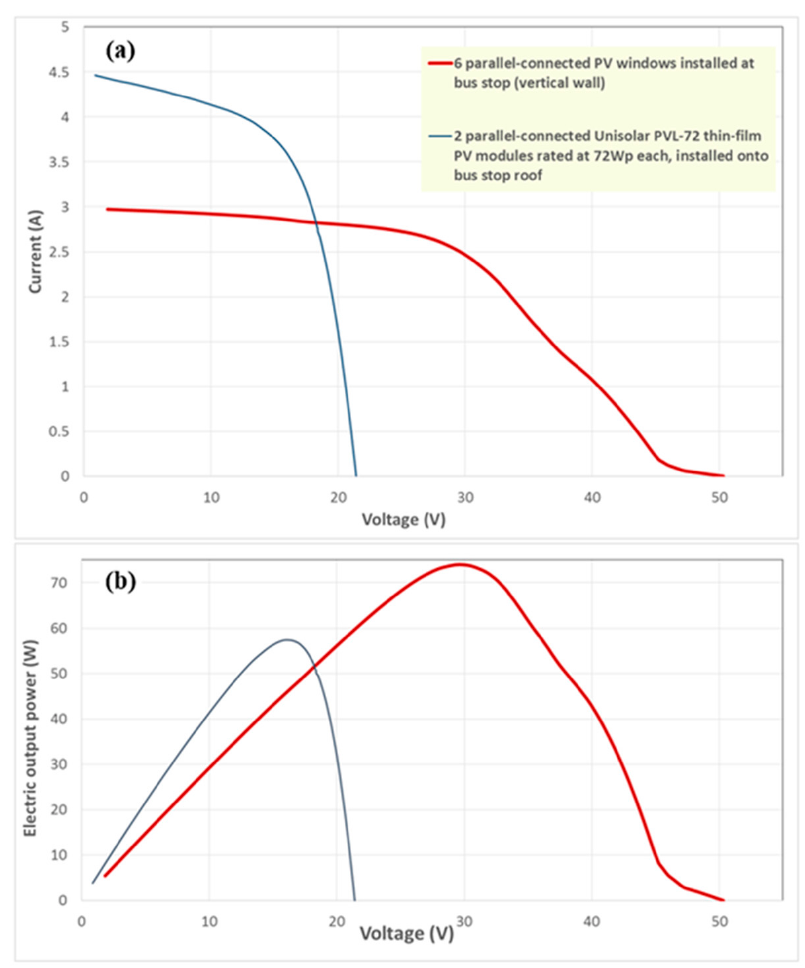
Figure 8. Measured PV I-V curves of a 6-window vertically-oriented bus-stop wall installation and comparison with a reference PV module output. ( a ) I-V curves of both PV modules measured concurrently in field conditions using PROVA 200A Solar Module Analyzer. ( b ) The corresponding power-voltage curves data.